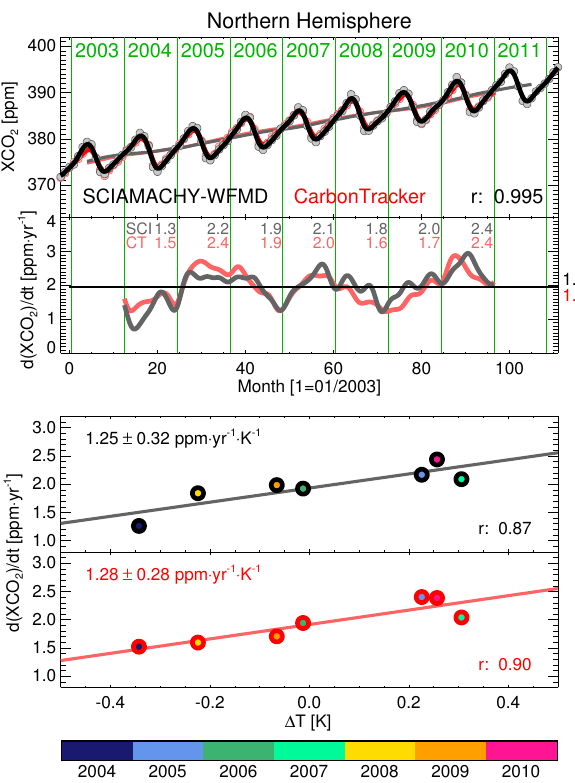
Fig. 3. Comparison of the SCIAMACHY (black) and Carbon- Tracker (red) XCO 2 for the Northern Hemisphere based on monthly means (coloured circles). The saturated solid lines have been smoothed using a four-month Hann window (which has a simi- lar frequency response to a two-month boxcar filter but better at- tenuation of high frequencies). The pale solid lines represent the corresponding deseasonalised trends derived using a 12-month run- ning mean. Shown below are the derivatives of these deseasonalised curves. Also noted are annual mean values of the growth rate (in pale colours) as well as the mean value of the whole time period on the right-hand side. The bottom panel shows the covariation of an- nual atmospheric growth rates and the Northern Hemisphere warm season (April–September) surface temperature anomaly.